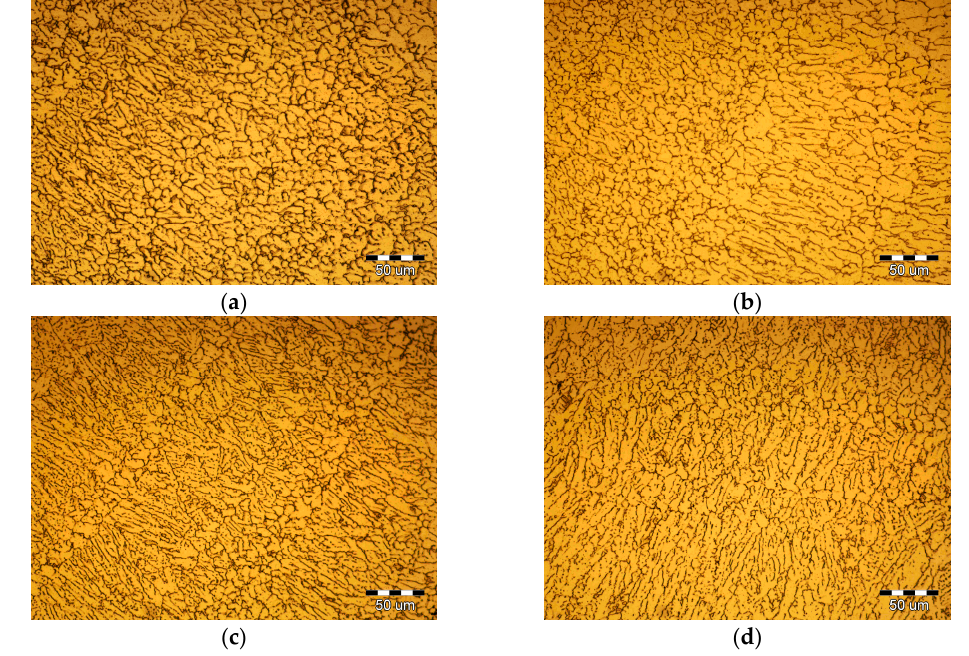
Figure 10. Effect of the pulse duty ratio δ on the PCALW weld microstructure for: ( a ) δ = 1/3; ( b ) δ = 1/2; ( c ) δ = 2/3; and ( d ) δ = 1.